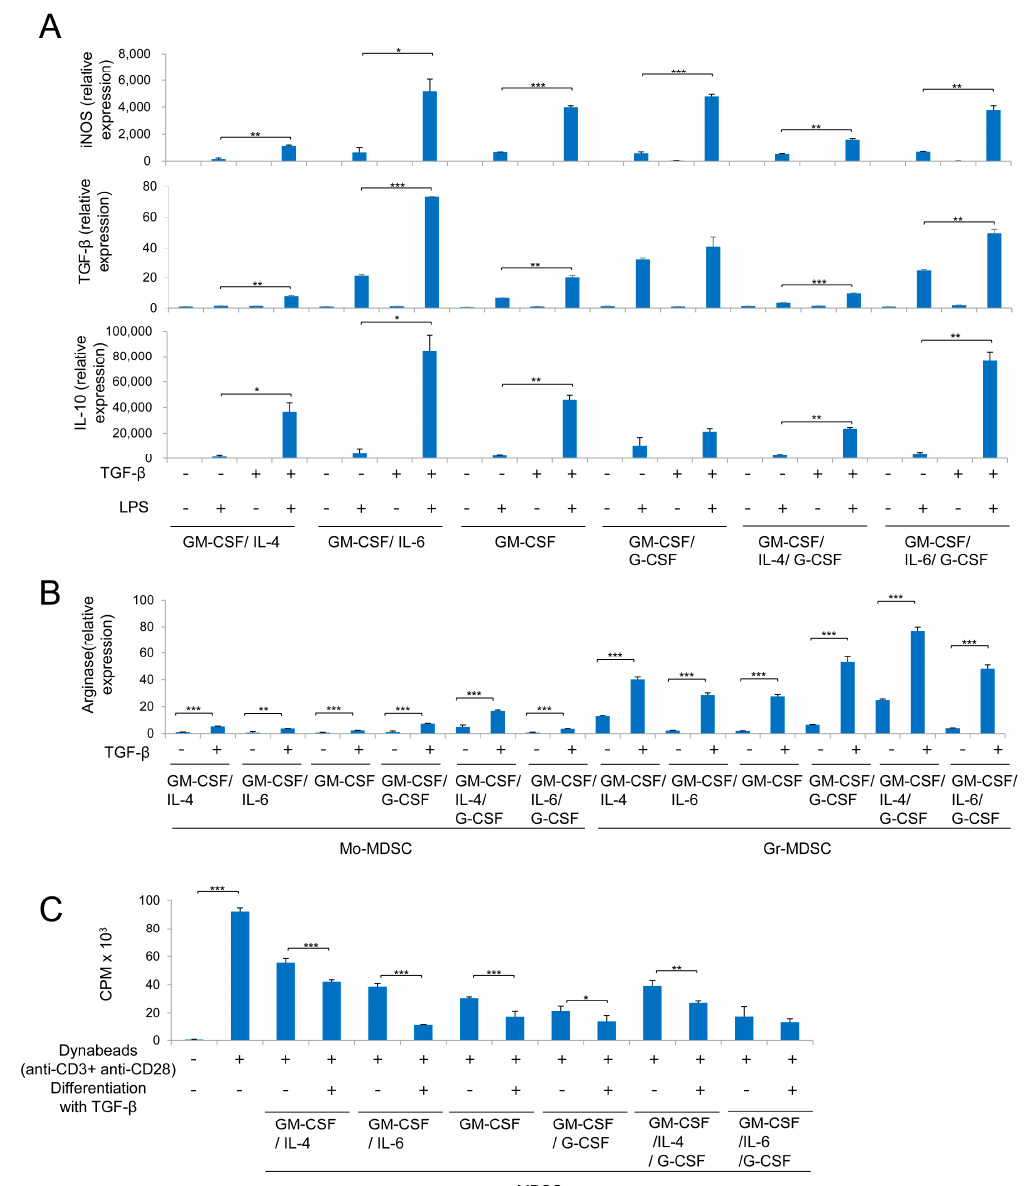
Figure 3. Immunosuppressive functions of the generated MDSCs. ( A ) Quantitative polymerase chain reaction (PCR) analysis of inducible nitric oxide synthase (iNOS), TGF- β , and interleukin-10 (IL-10) expression by isolated Mo-MDSCs in the presence/absence of lipopolysaccharide (LPS) and TGF- β ; ( B ) quantitative PCR analysis of Arginase 1 (Arg1) expression by isolated Mo-MDSC and Gr-MDSCs; ( C ) cytokine-induced MDSCs were isolated and cocultured with CD4 + T cells. CD4 + T cells were then stimulated with anti-CD3- and anti-CD28-coated Dynabeads and labeled with 3H-thymidine. The effector:target ratios (MDSCs: CD4 + T cells) were 1:3. GM-CSF, granulocyte-macrophage colony stimulating factor; IL-4, interleukin-4; IL-6, interlukin-6; G-CSF, granulocyte colony stimulating factor; Data are representative of three independent experiments ( A – C ), and results are expressed as the mean ± SD. * p < 0.05, ** p < 0.01, *** p < 0.001 (Student’s t test).